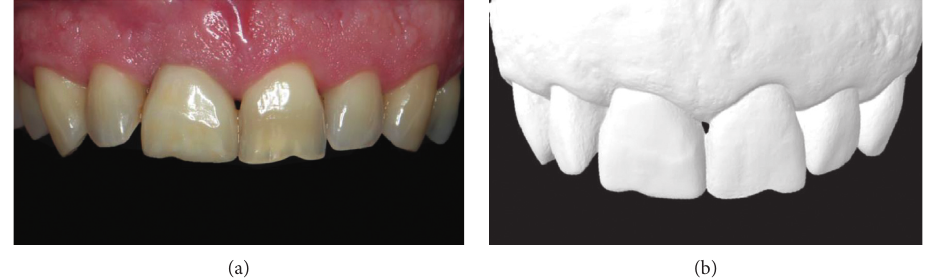
Figure 1: Dental records obtained from a male patient who had the right central incisor restored with a single implant-supported crown. (a) Maxillary anterior region with retracted cheeks and lips. (b) Digital image generated from the intraoral scanner.